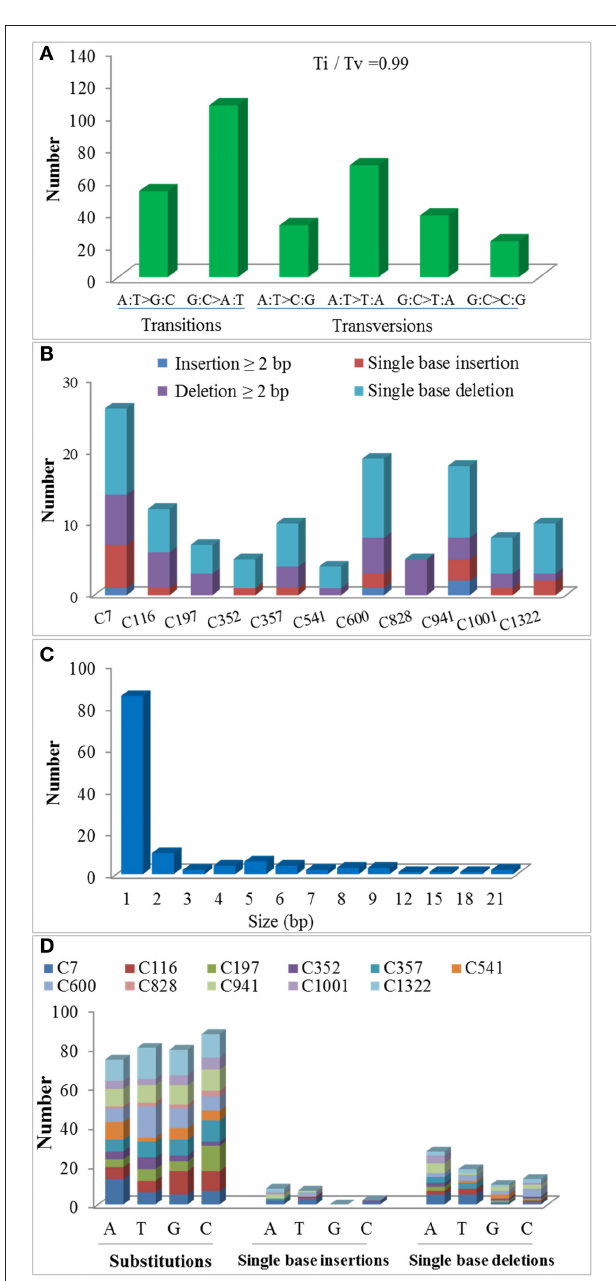
FIGURE 8 | Molecular spectrum of CIB irradiation induced substitutions and small INDELs in the genomes of 11 M3 lines. (A) The ratio of transition to transversion (Ti/Tv). (B,C) Size distributions of the small INDELs. (D) Base bias of CIB irradiation-induced single base